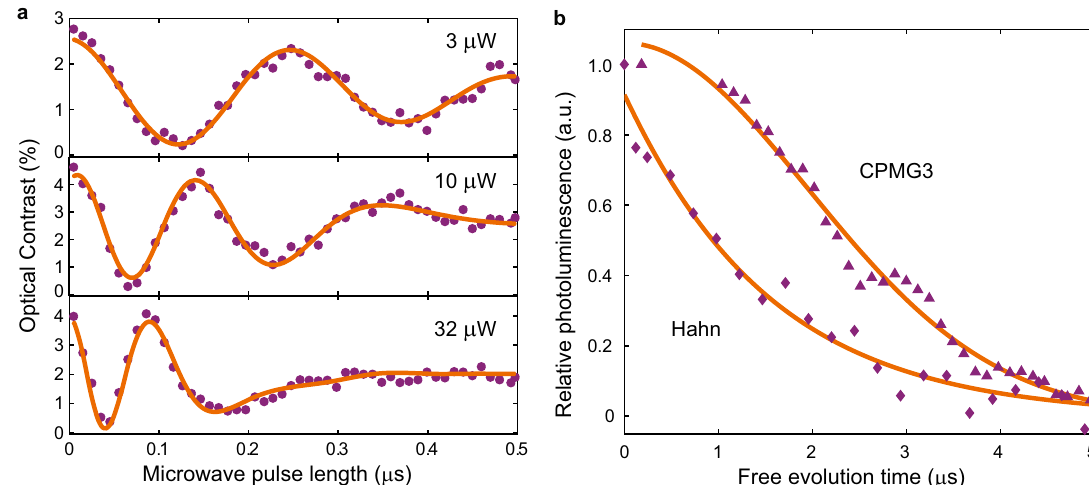
Fig. 3 Spin wave mediated coherent driving of NV centers. a , Rabi oscillations measured on NP-Q at a fi xed external magnetic fi eld (120 G) and different microwave powers. The nanoparticle is located 20 μ m away from the driving MSL. b , Hahn-echo and Carr-Purcell-Meiboom-Gill 3 π pulse (CPMG3) measurements that show robust multi-pulse control of the NV centers. Both sets of data are renormalized and fi t to exp[-(t/T 2 ) α ], where α = 1 and 2 for the Hahn and CPMG3 case, respectively. From these fi ts we obtain T 2,Hahn = 1.54 μ s and T 2,CPMG3 = 2.78 μ